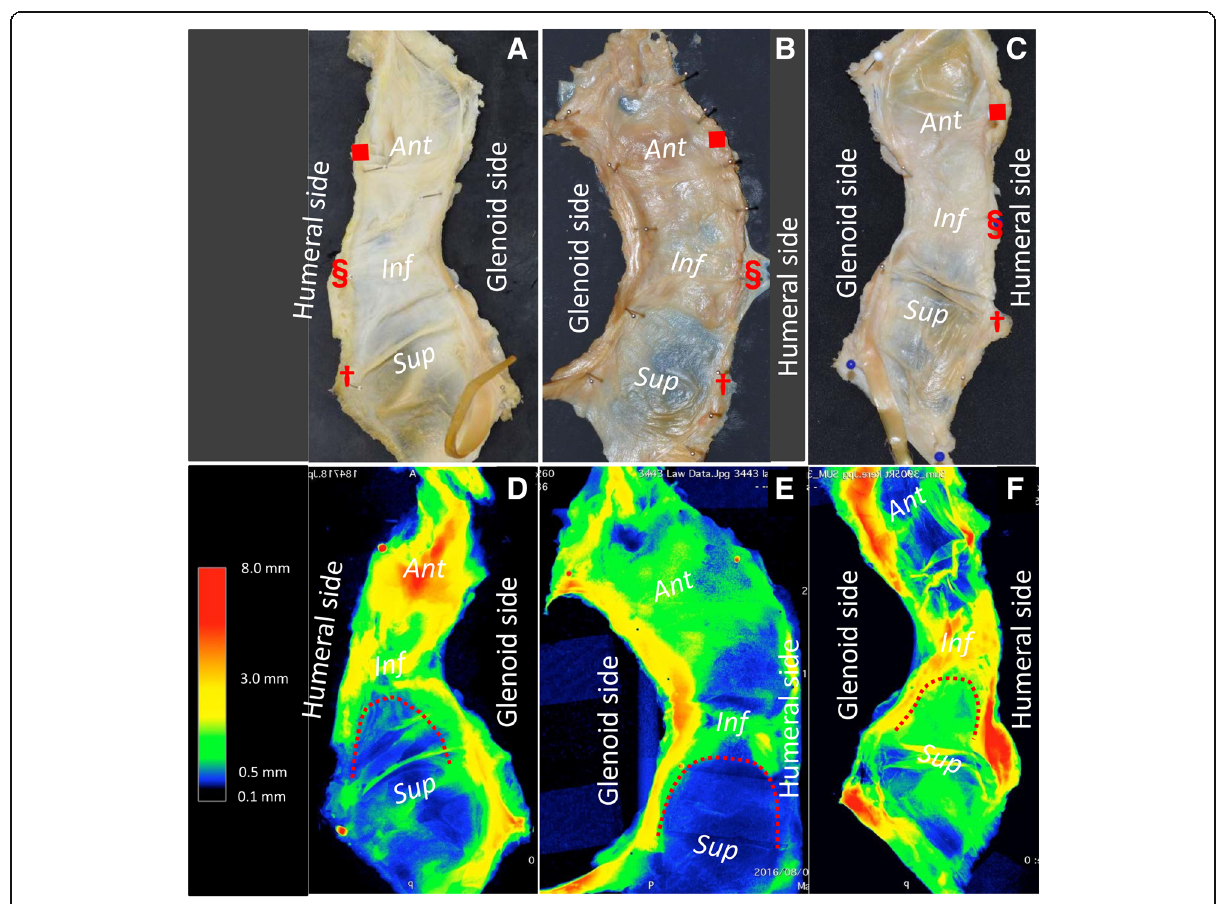
of the whole capsule ( a , b , and c ) corresponds to 3D images with micro-CT ( d , e , and f ), respectively. The color bar represents approximate thickness (mm) corresponding to the colors. Inferior parts of the capsule, colored red, yellow, and green, were consistently thicker than the superior part, colored green, blue, black. However, the anterior part seemed variable in comparison with the inferior part. In addition, the thick inferior part of the capsule continued to the superior area along the glenoid and humeral side edge (red dotted lines in d , e , and f ). Ant , anterior; Inf , inferior; Sup ,